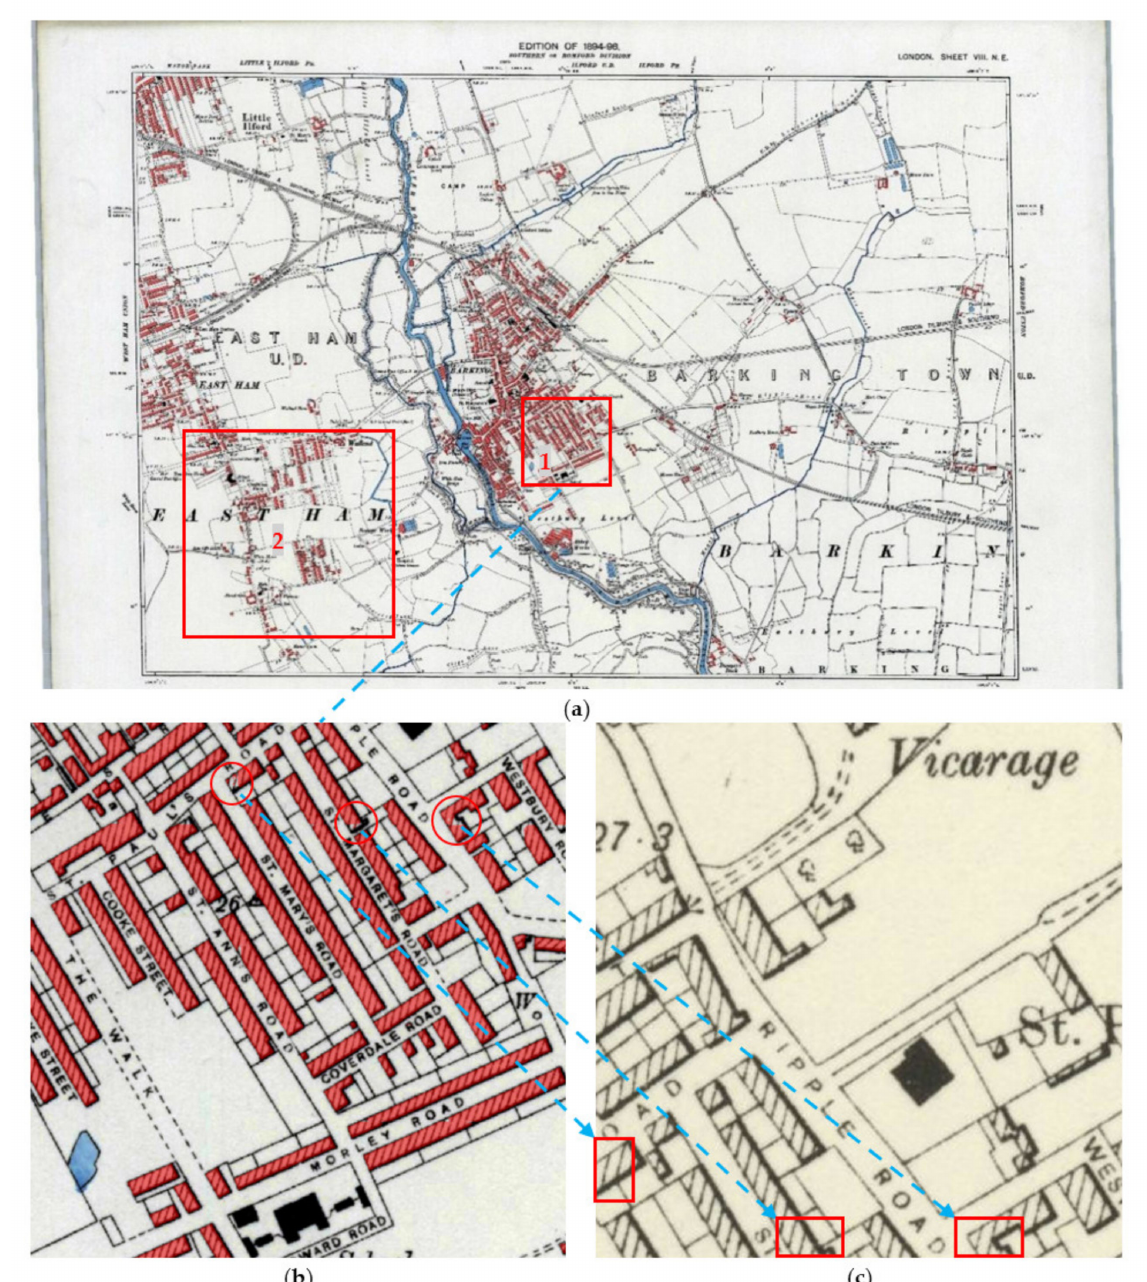
Figure 10. Extraction results of hatched residential areas from a raster map. ( a ) 1894–1896 historical raster map of Northeast London; ( b ) enlarged view of area 1; ( c ) small cut image with a size of 356 × 362